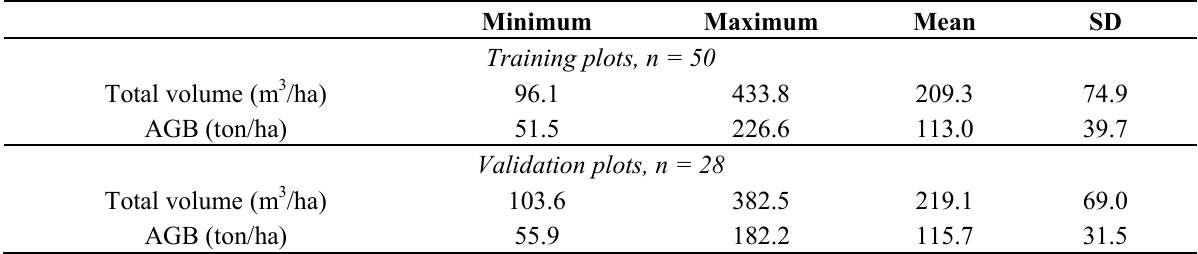
Table 2. The mean characteristics of the training plots and validation